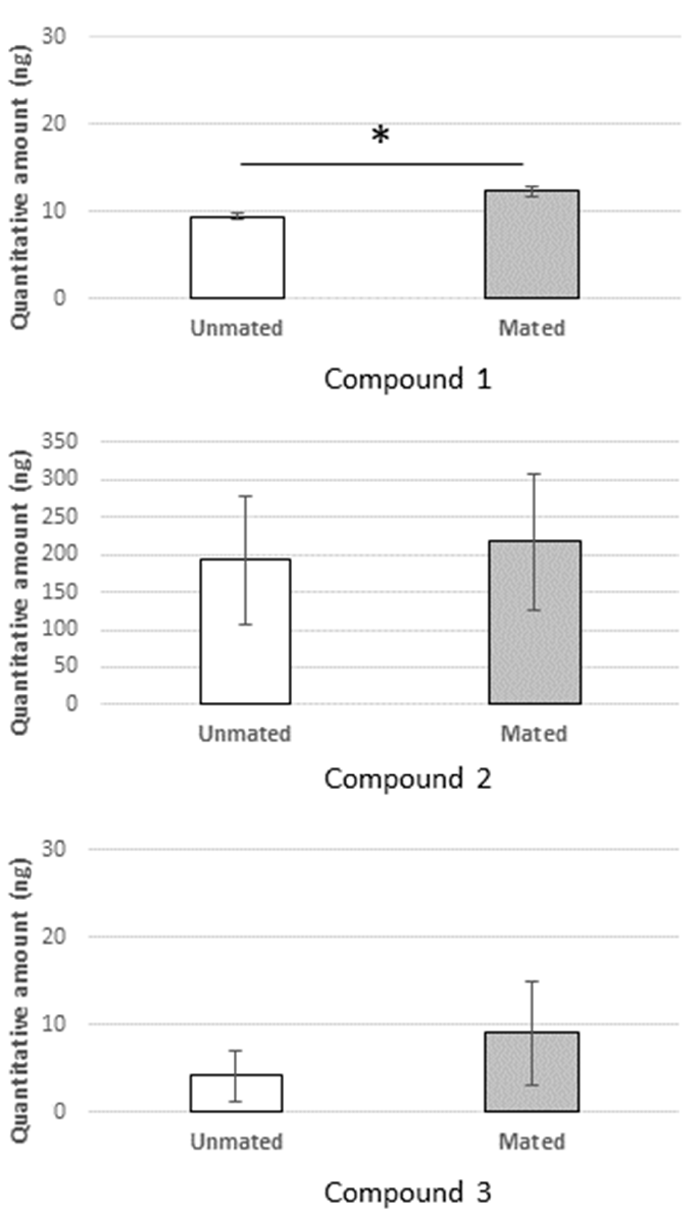
Figure 3. Pheromone production (compound 1 , 2 , and 3 ) in the mated and unmated adult male L. africanus . Error bar represents the standard deviation, asterisk indicates a significant difference ( p < 0.05). Table 1. Mean production of pheromone compounds by L. africanus at different